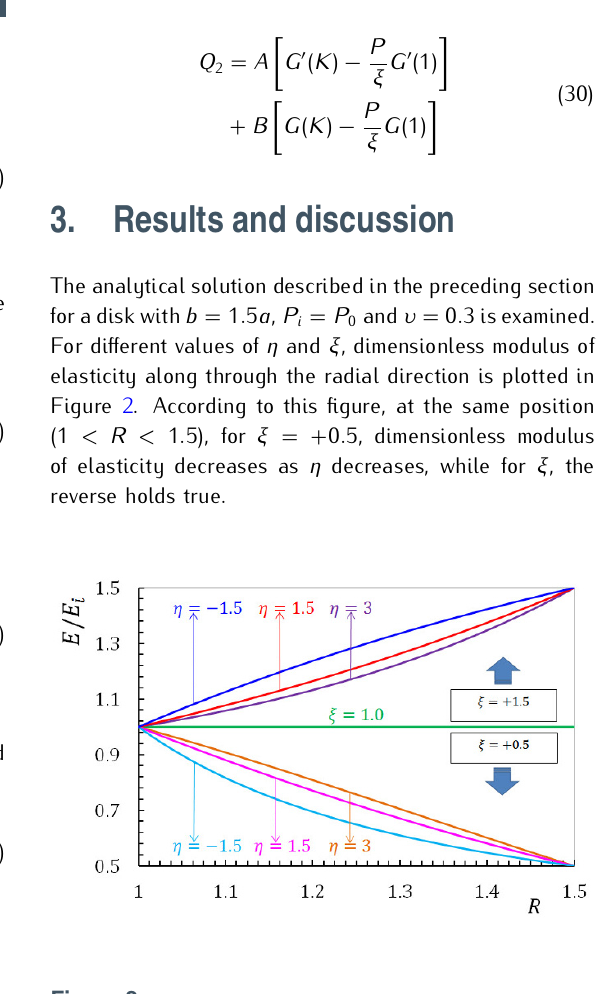
Figure 2. Radial distribution of modulus of